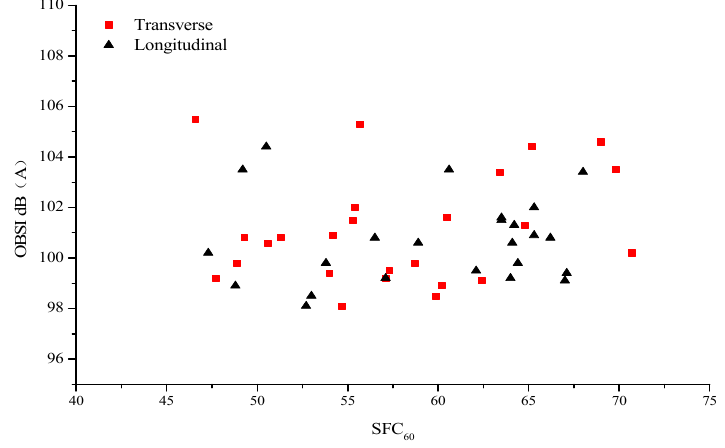
Figure 6. Regression analysis between side-way force coefficient (SFC) and tire/road noise.